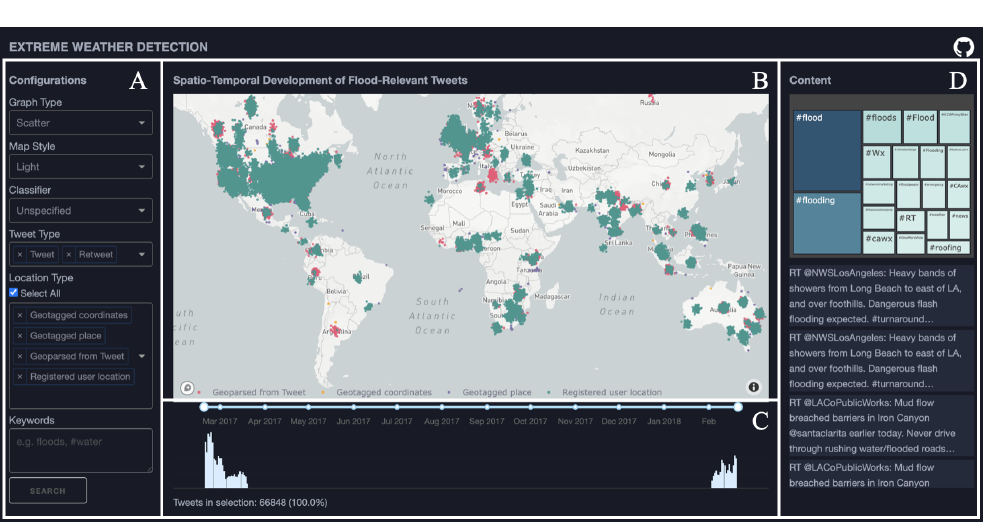
Figure 8. The visual interface organised in multiple coordinated views: ( A ). Selection pane, ( B ). Spatial data, ( C ). Temporal data and ( D ). Textual